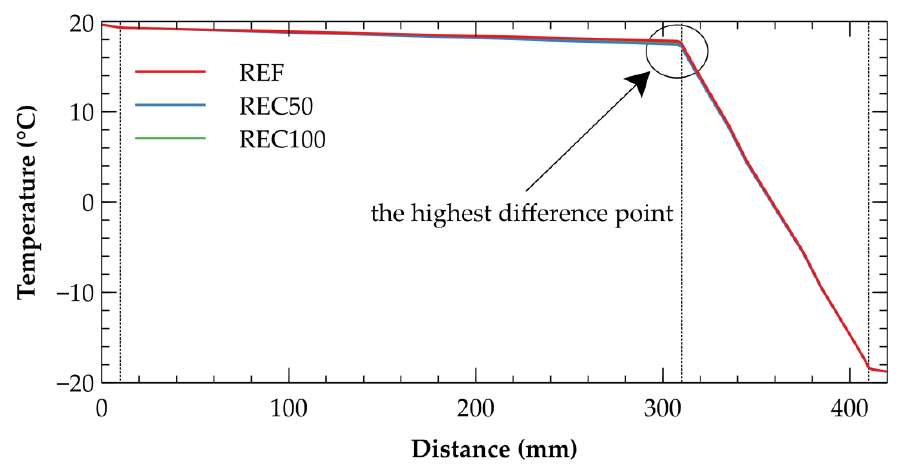
Figure 11. Comparison of temperature profiles as of 12 January of the reference year. The position 0 mm denotes the interior side of the wall, the position 420 mm denotes the exterior side.